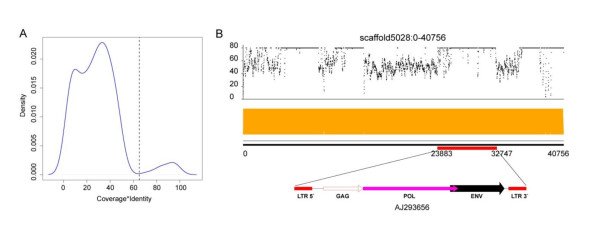
PERVs in the WZSP genome. (A) Distribution of similarity between virus protein and its counterpart in WZSP genome by considering factors of sequence identity and coverage. (B) Structure of whole PERV genome inserted into the pig genome. The upper panel shows the sequencing depth of the assembled scaffold. The middle panel visualizes the paired-end alignment of the scaffold providing evidence of correct assembly. The bottom panel shows the genome structure of PERV and its integration site in the scaffold.